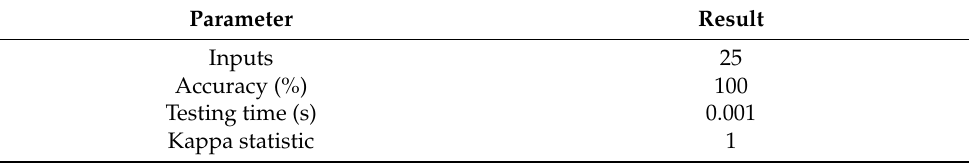
Table 3. ANN Parameters and accuracy for classification testing of the 3D FEM Model.